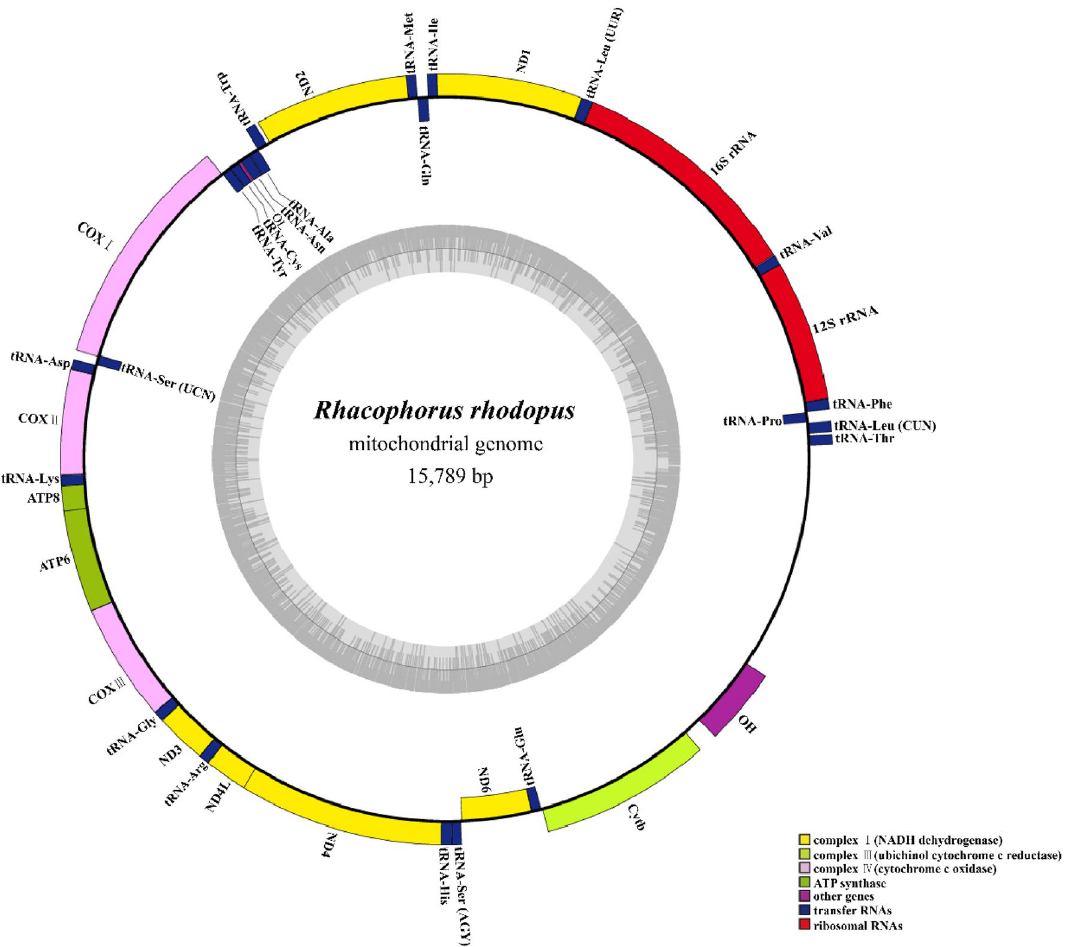
Figure 2. The complete mitochondrial genome sequence of Rhacophorus rhodopus collected from Motuo County in The AT/CG-skews of the 12 PCGs are listed in Table S3. Except for ND2, ND6 and COX II, the remaining nine PCGs were negative in both the AT-skew and GC-skew. Meanwhile, the A + T content of the 12 PCGs was 60.37%; the AT-skew (− 0.074) and the GC-skew (− 0.253) were negative. The codon usage and relative synony- mous codon usage (RSCU) values of R. rhodopus are shown in Table S3. Eight of 64 codons showed the highest use frequency and they were AUU (192), UUU (161), CUA (141), UUA (133), AUA (133), ACA (105), GCC (100), CUU (100). However, UCG and CGG codons were the least used stop codon. Ribosomal RNA and transfer RNA genes. Similar to other vertebrates 21 , the mitogenome of R. rhodo- pus also included 12S and 16S rRNA genes, which were on the H strand. The 12S rRNA gene was 935 bp long and located between tRNA- Phe and tRNA- Val genes. The 16S rRNA gene with a length of 1,572 bp was located between tRNA- Val and tRNA- Leu (UUR) genes (Table S1). We found that the content of A + T (12S rRNA genes 54.55%, 16S rRNA genes 60.56%) was higher than that of C + G (12S rRNA genes 45.45%, 16S rRNA genes 39.44%). The AT-skew was slightly positive whereas the GC-skew was strongly negative (Table S2). Of the 22 tRNA genes identified in the R. rhodopus mitogenome, 14 genes were located on the H strand and 8 genes were located on the L strand (Table S1). The secondary structure of tRNA is shown in Fig. 3. We found that 21 tRNA genes, except for tRNA- Ser (AGY), were able to form the classical cloverleaf secondary structure and that the use of anticodon was the same in other vertebrates 3 . In contrast, the tRNA- Ser (AGY) gene was unable to form a cloverleaf structure due to a lack of a dihydrouridine (DHU) arm. This is a common phenomenon in vertebrates 27 . However, Cheng et al.suggested that lack of DHU could become functional by adjusting its struc- tural conformation to fit the ribosome in a similar way to that of usual tRNAs in the ribosomes 28 . Noncoding regions. We identified two major noncoding regions in the R. rhodopus mitochondrial genome, at the origin of L-strand replication (OL) and in the control region (D-loop). The OL, a length of 23 bp, was located between tRNA- Asn and tRNA- Cys in the WANCY genes cluster (Table S1). The D-loop (2,230 bp), which was the longest part in the complete genome, was located between the Cytb gene and the tRNA- Thr gene on the H-strand (Table S1). Keddie et al. speculated that the D-loop may play an important role in gene replication 29 .